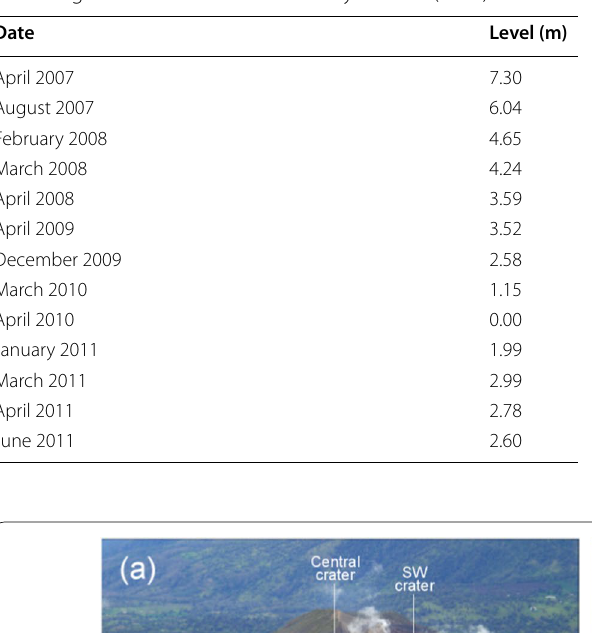
Table 1 Level variations of Irazú crater lake: levels of the lake were measured by comparing photos taken in different times according to the method established by Rouwet (2011)